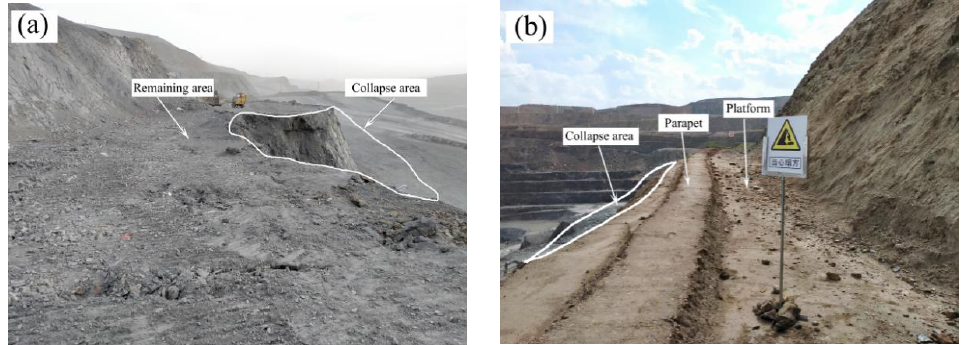
Figure 1. Shallow damage bench: ( a ) Carbonaceous slate bench collapse; ( b ) Repaired soft rock